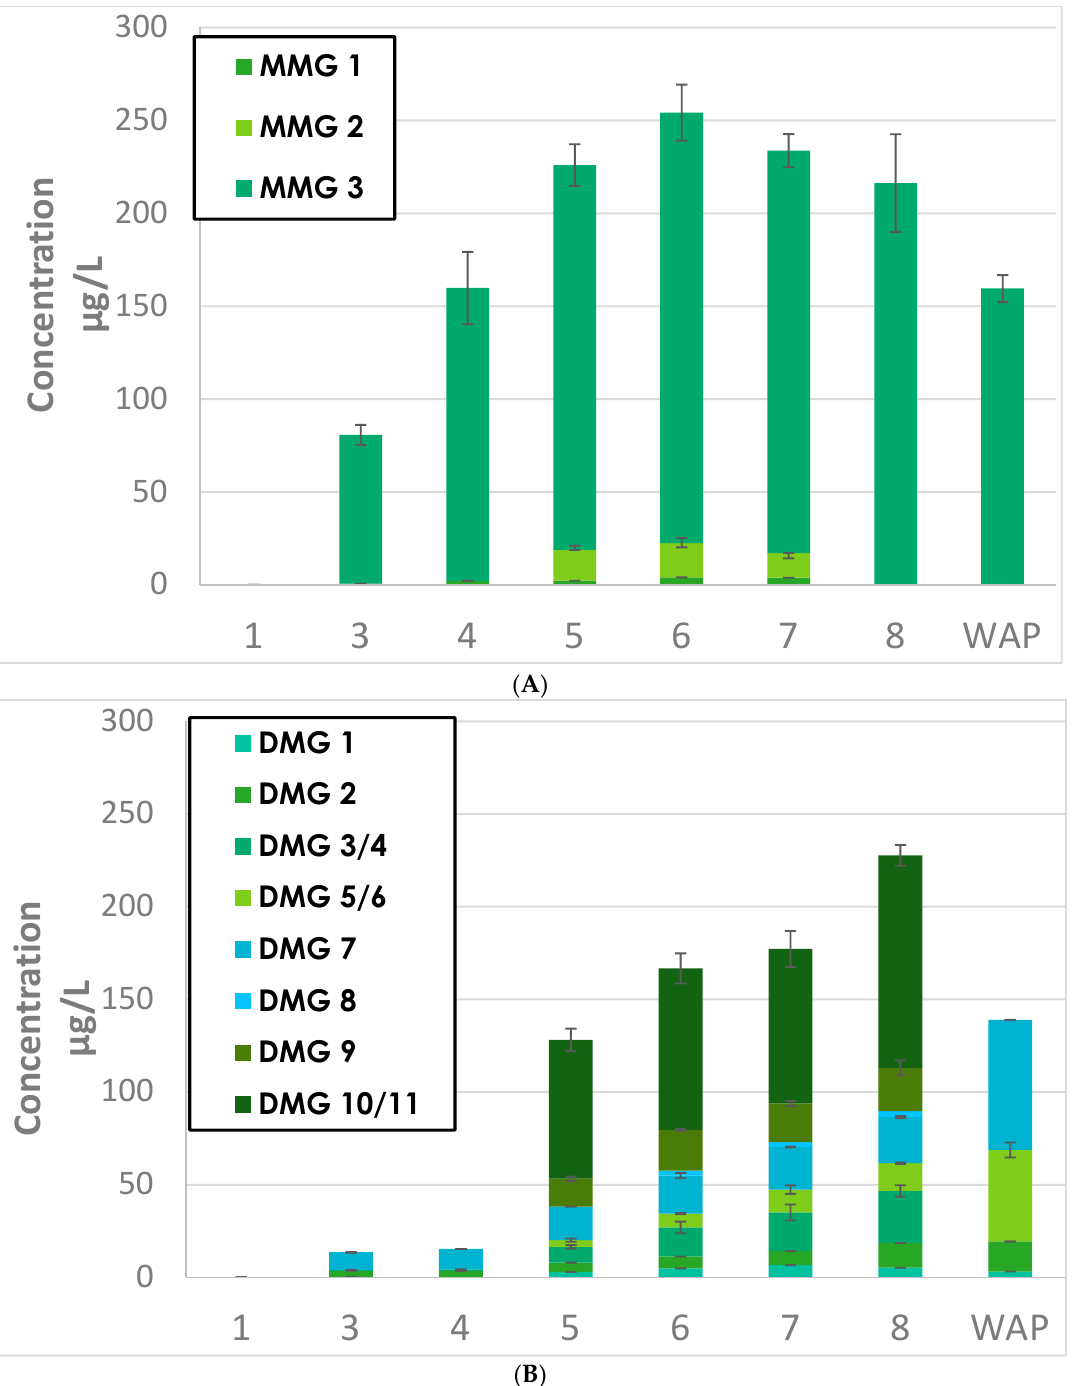
Figure 2. Evolution of ( A ) monomers of (epi) catechin monoglycosides (MMG) and ( B ) dimers of (epi) catechin monoglycosides (DMG) isomers during Grenache (GRE) fermentation. WAP = wine after pressing.